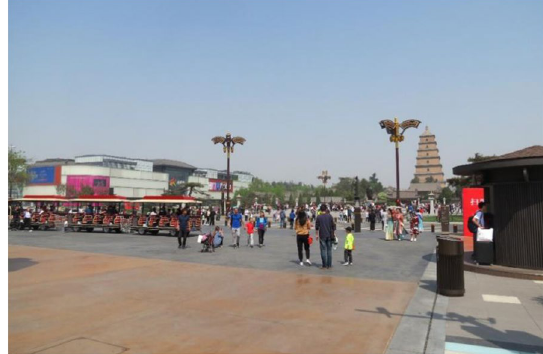
Fig. 2 An image of the shopping area to the south of the Giant Wild